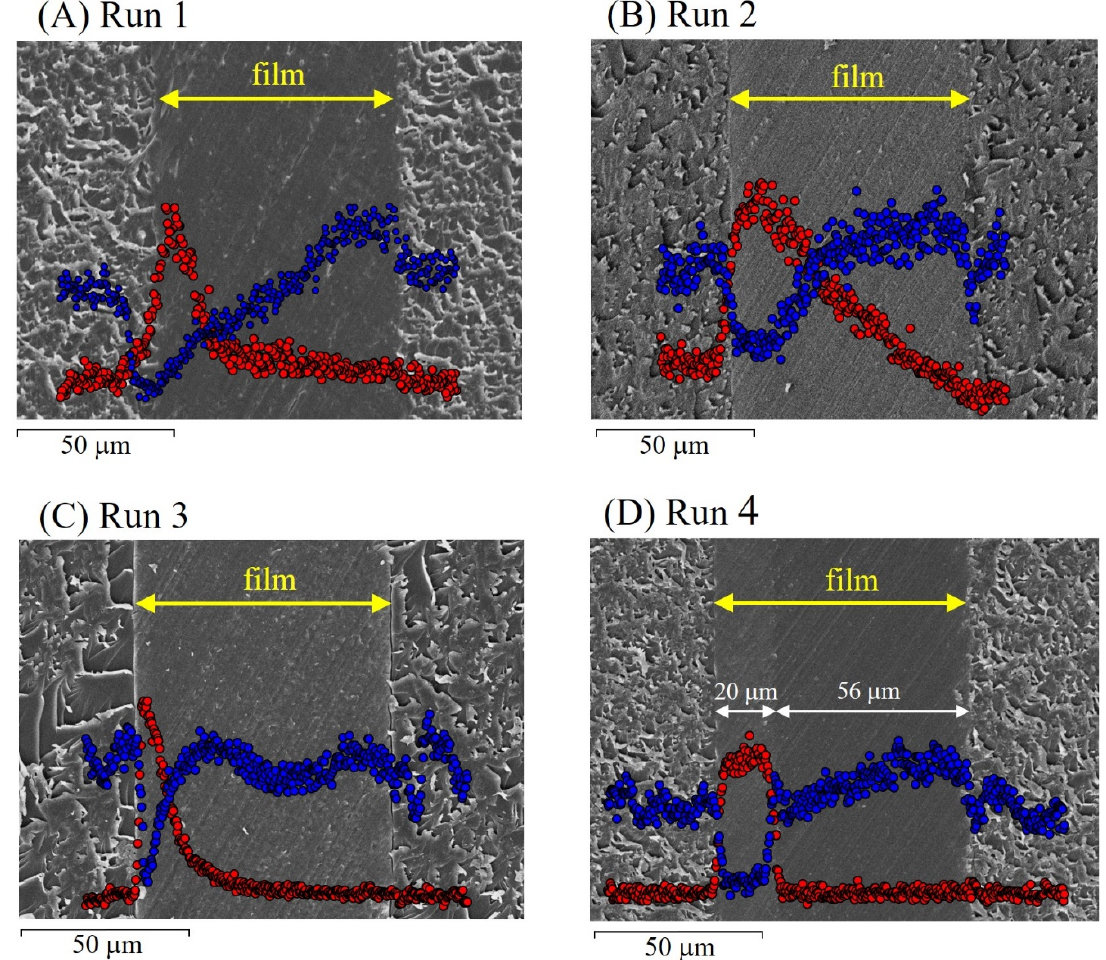
Figure 4. SEM images and concentration profile of sulfur (red circle) and chlorine (blue circle) of the grafted PVDF (( A , B )) and poly(ethylene- co -tetrafluoroethylene) (ETFE) (( C , D )) films prepared in Runs 1–4 in Table 4. Sulfur is contained in SSS and ethyl p -styrenesulfonate (EtSS) units, and chlorine is contained in CMS units.